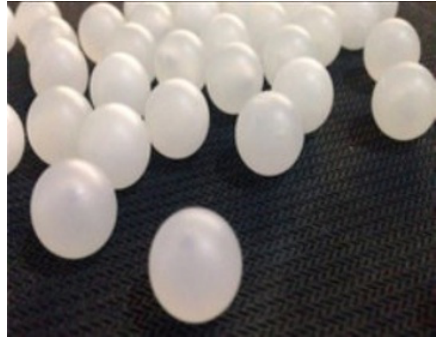
Fig. 2. The precise calibration spheres ”Nylon 6/6 Balls”.